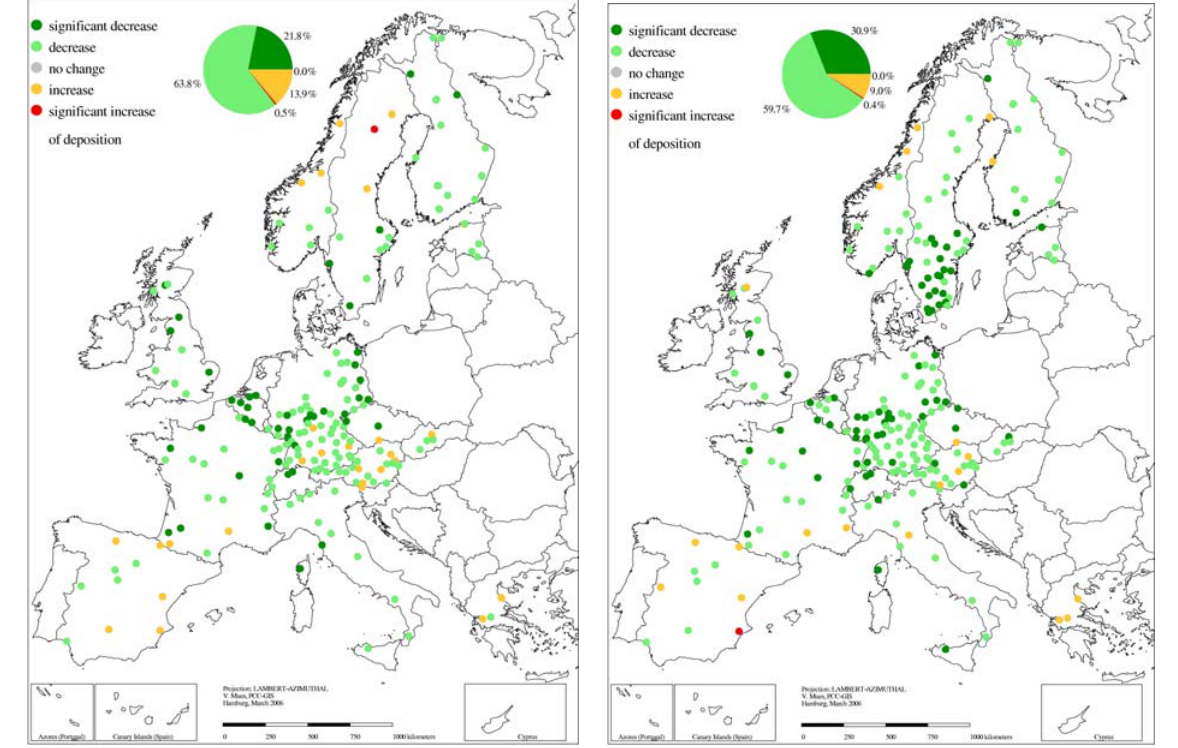
FIGURE 3. Temporal change in bulk (left) and throughfall (right) deposition of S-SO 42– from